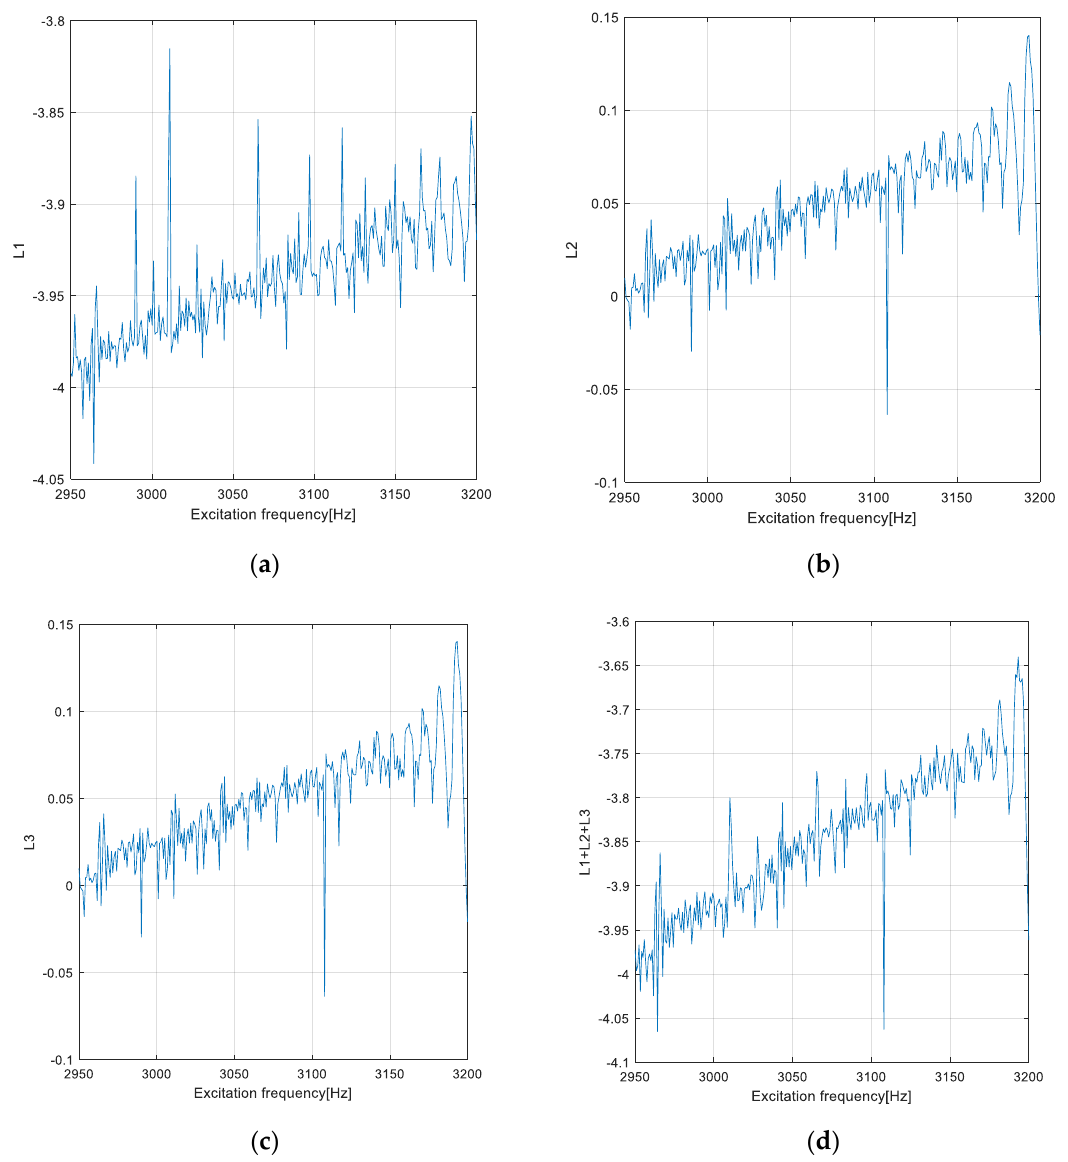
Figure 20. Lyapunov exponents of Nonstationary FTV for DIE1, 0